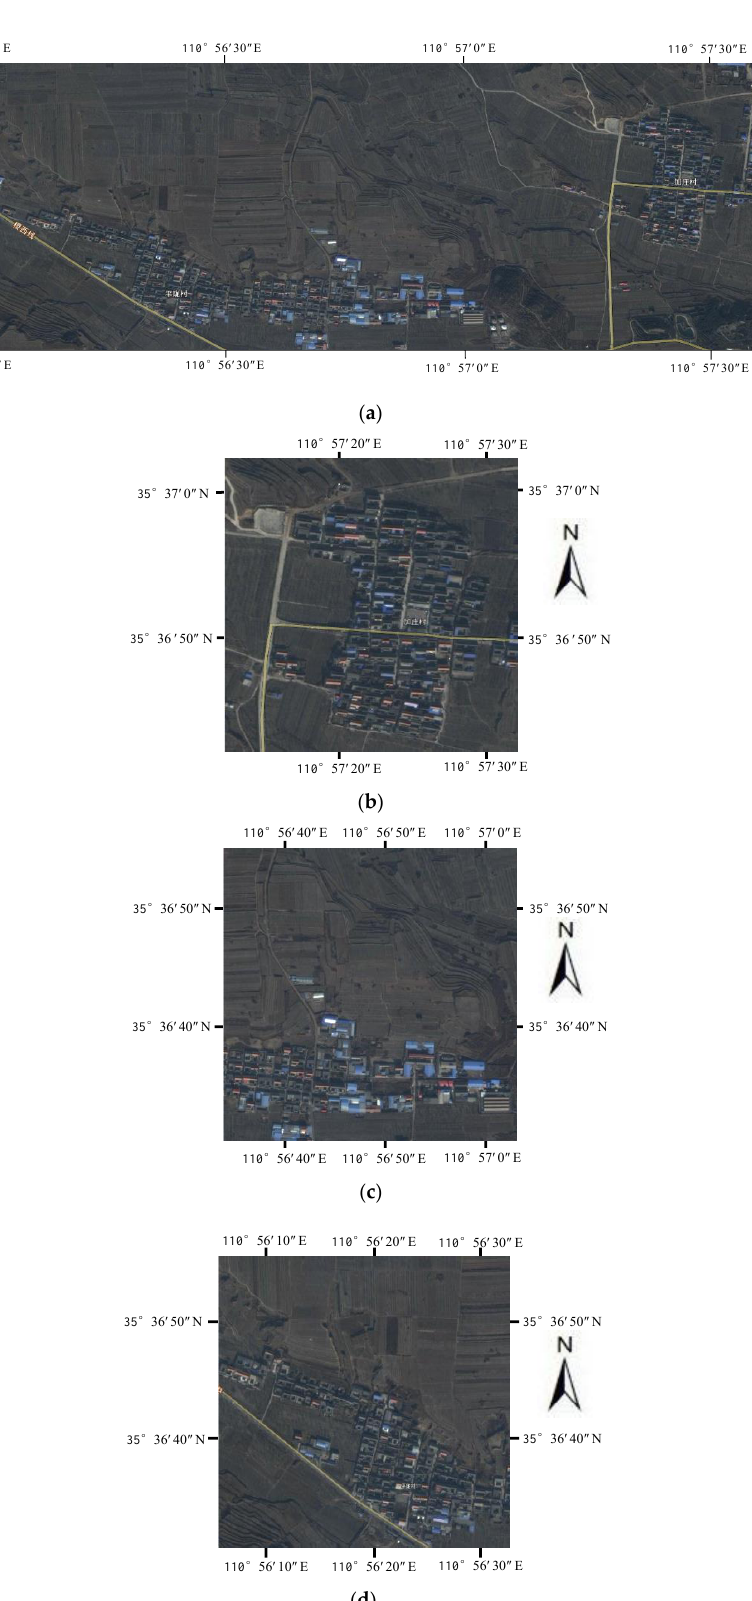
Figure 7. Optical image of experimental and evaluation areas. ( a ) Optical image of experimental areas. ( b – d ) Optical image of Site A to B.